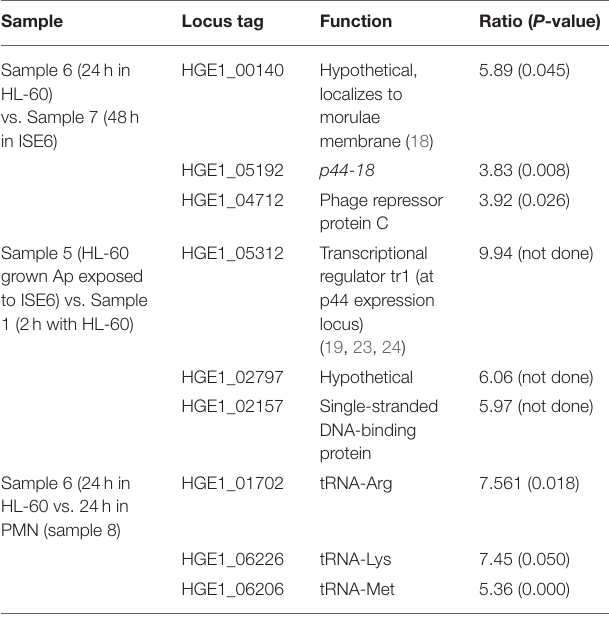
TABLE 2 | Most differentially regulated genes in the cell culture systems used in this study. Sample Locus tag Function Ratio ( P -value) Sample 6 (24h in HL-60) vs. Sample 7 (48h in